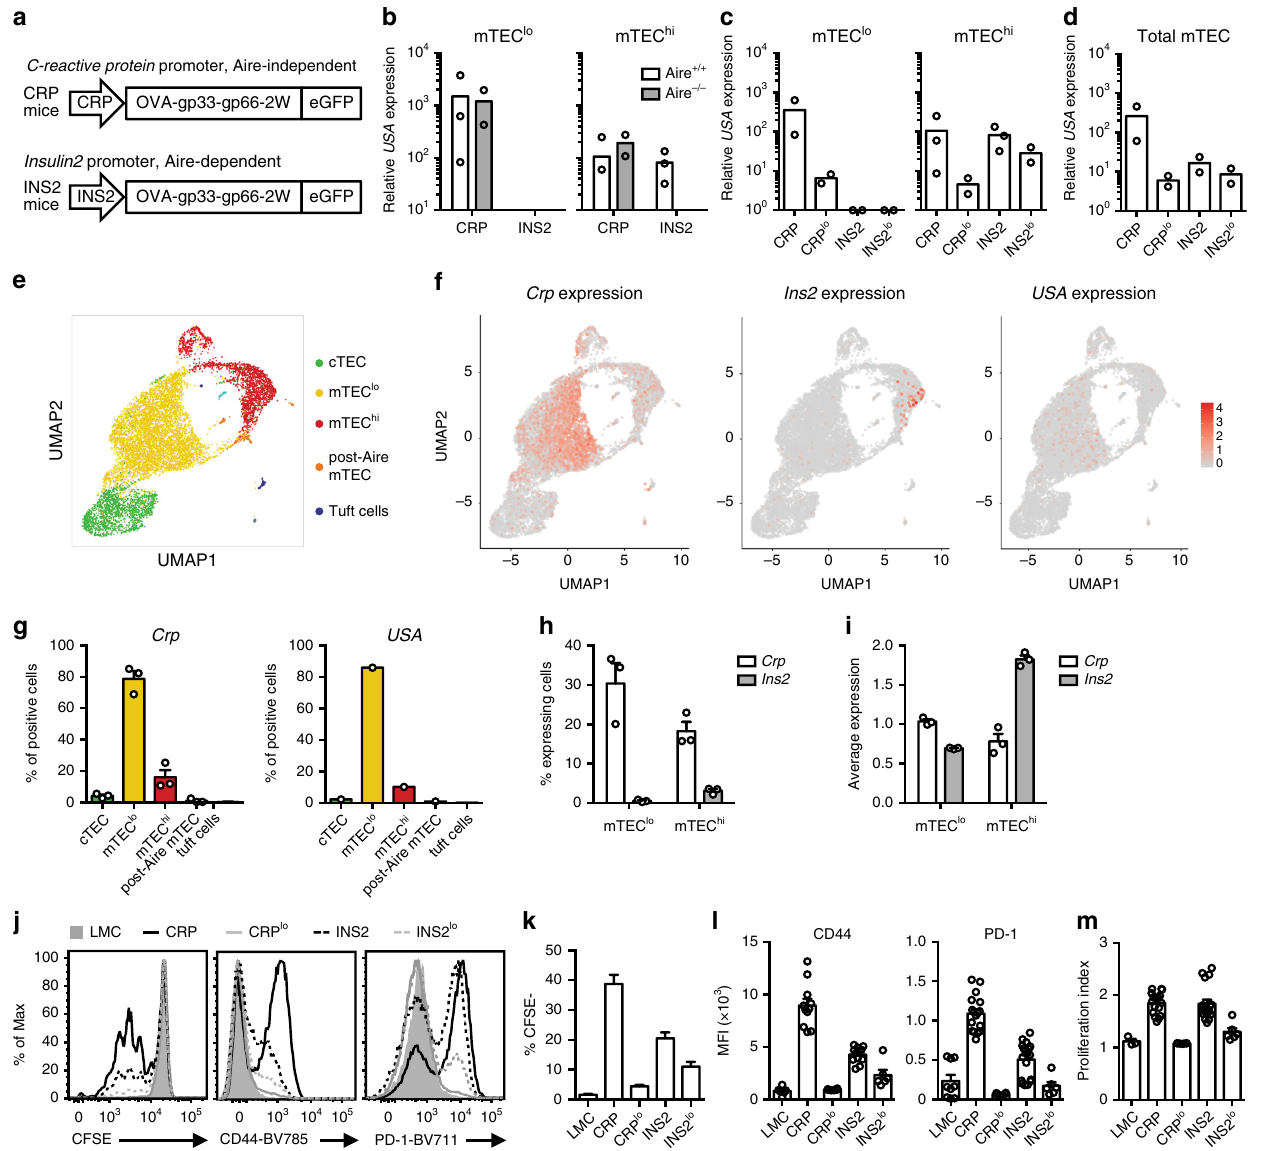
Fig. 1 Crp and Ins2 promoters drive model antigen expression in distinct patterns among mTEC subsets. a Tg mouse constructs. b Relative USA expression in sorted mTEC lo and mTEC hi from Aire + / + or Aire − / − CRP and INS2 Tg mice. c USA mRNA expression in mTEC lo and mTEC hi from CRP, CRP lo , INS2 and INS2 lo Tg mice. d Calculation of USA mRNA expression in total mTEC. The thymus from three mice were pooled together prior to sorting, and data are representative of at least two independent experiments. e – i Single-cell RNA sequencing of total thymic epithelial cells (TEC) from CRP, CRP lo , and INS2 Tg mice. e Uniform Manifold Approximation and Projection (UMAP) of TEC from CRP Tg mice. f UMAP highlighting Crp , Ins2 , and USA transgene expression in TEC from CRP Tg mice. g Distribution of the Crp- or USA -expressing cells among the different TEC clusters isolated from the three Tg mice ( Crp ) or from CRP Tg mice ( USA ). h Proportion of mTEC lo and mTEC hi cells that express Crp or Ins2 from the three Tg mice. i Average log-normalized per cell expression of Crp and Ins2 among mTEC lo and mTEC hi isolated from the three Tg mice. Data from g – i are from one experiment with one mouse per Tg line and are represented as mean ± SEM for analysis of Crp and Ins2 . j Representative histograms of mature OT-I T cell proliferation and activation 72 h after overlay on the indicated thymic slices as indicated by CFSE dilution as well as CD44 and PD-1 expression. k Compilation of the proportion of CFSE lo OT-I T cells 72 h after overlay on the indicated thymic slices (mean ± SEM, n = 12 LMC, 23 CRP, 15 CRP lo , 24 INS2, 15 INS2 lo , from 3 independent experiments). l Compilation of the mean fl uorescence intensity (MFI) of CD44 and PD-1 and m the proliferation index of the proliferating mature OT-I T cells. Littermate control (LMC) (mean ± SEM, n = 3 LMC, 17 CRP, 6 CRP lo , 18 INS2, 6 INS2 lo , from 3 independent experiments). Source data are provided as a Source Data fi endogenous Crp and CRP transgene expression in bulk mTEC lo Ins2 expression at a single-cell level in TEC isolated from the three Tg mice reveals differences between these two TRA in the vs mTEC hi as determined by qPCR (Supplementary Fig. 1b and mTEC hi subset; Crp is expressed in a greater proportion of Fig. 1b, c), is further explained by the single-cell RNA sequencing mTEC hi , but at lower levels on a per cell basis while endogenous data. A higher proportion of mTEC lo express Crp , but Crp Ins2 is expressed in very few mTEC hi cells, but at a relatively expression in individual cells is similar between these two mTEC higher level in individual cells (Fig. 1h, i). In addition, the higher subtypes (Fig. 1h, i); the same is true for USA expression among